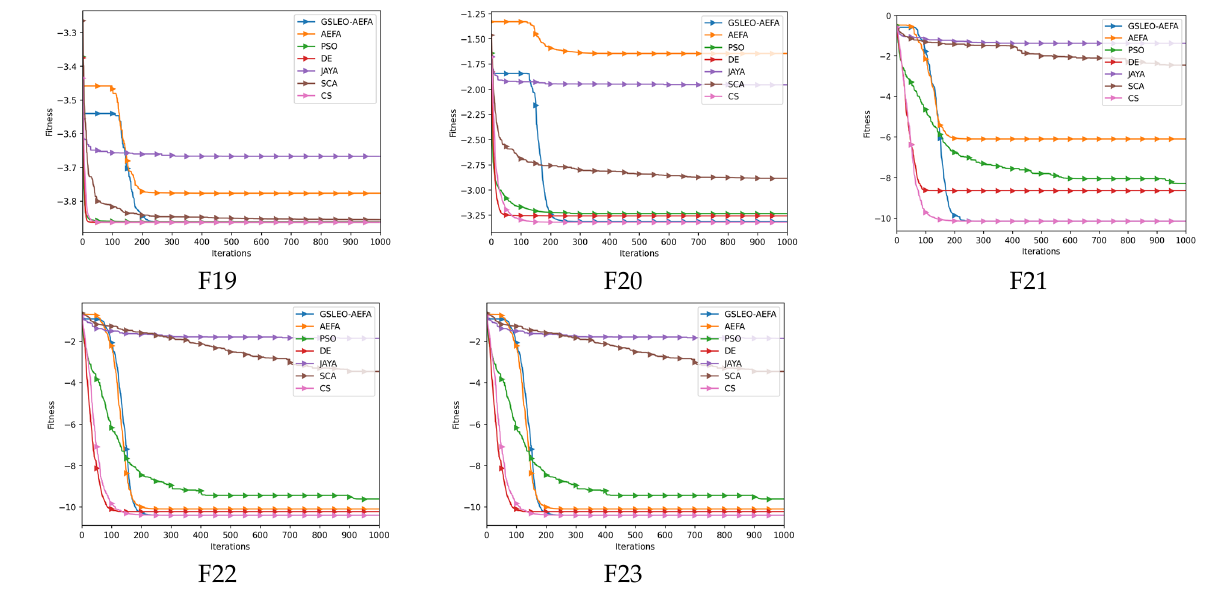
Figure 4. Convergence trajectory graphs for all studied benchmark functions F1–F23.